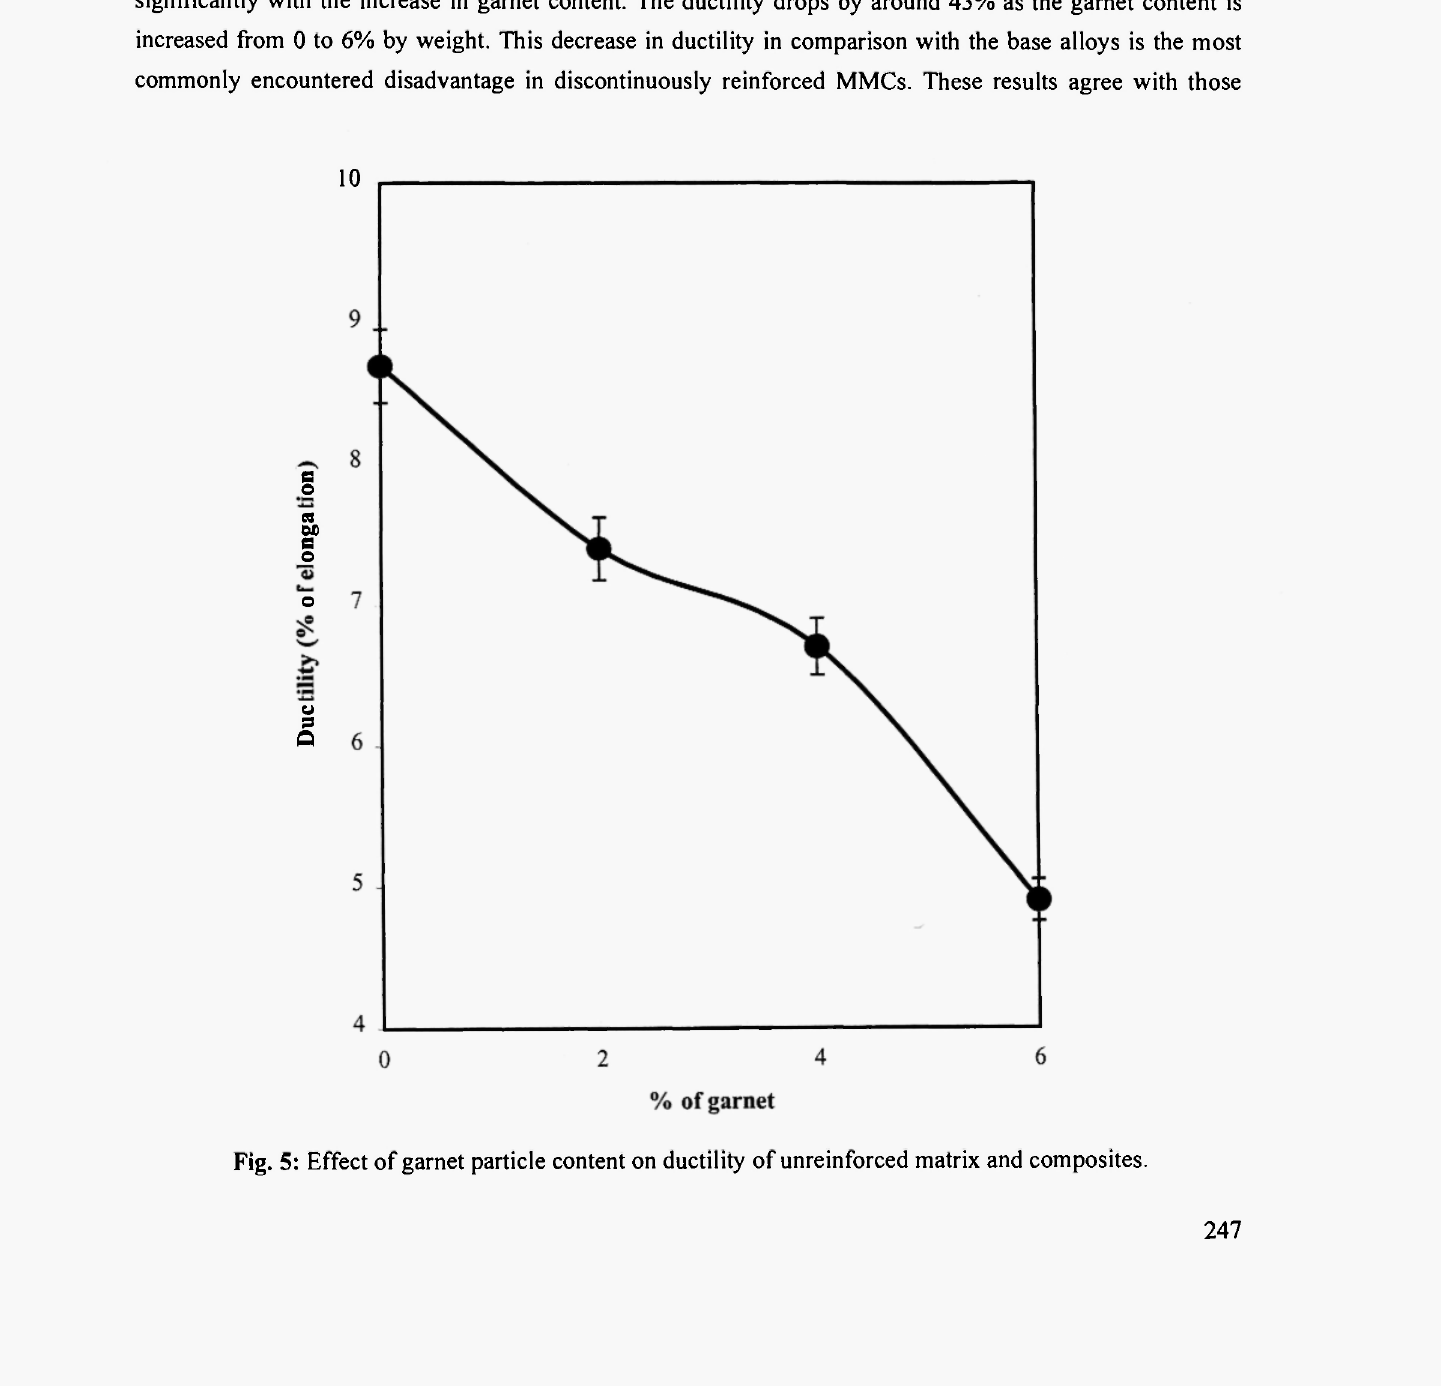
Fig. 5: Effect of garnet particle content on ductility of unreinforced matrix and